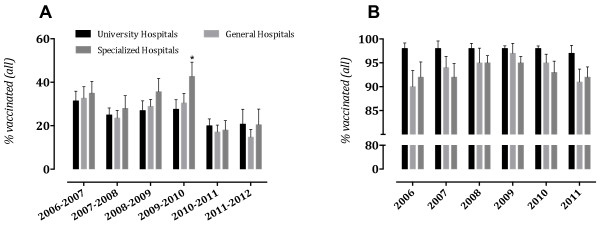
Seasonal influenza (Panel A) and HBV (Panel B) vaccination coverage among HCWs in Croatian hospitals, stratified by type of hospital. Medians with interquartile ranges were plotted. In 2009–2010, significant increase in vaccination coverage in long-term care and specialized hospitals was observed (p = 0.03) (Panel A). In the following post-pandemic seasons, significant decrease in all the groups was observed (p < 0.0001, Kruskal–Wallis) (Panel A). (Panel B) shows significant differences between university and general (p = 0.015), and university and long-term care and specialized hospitals (p = 0.006).